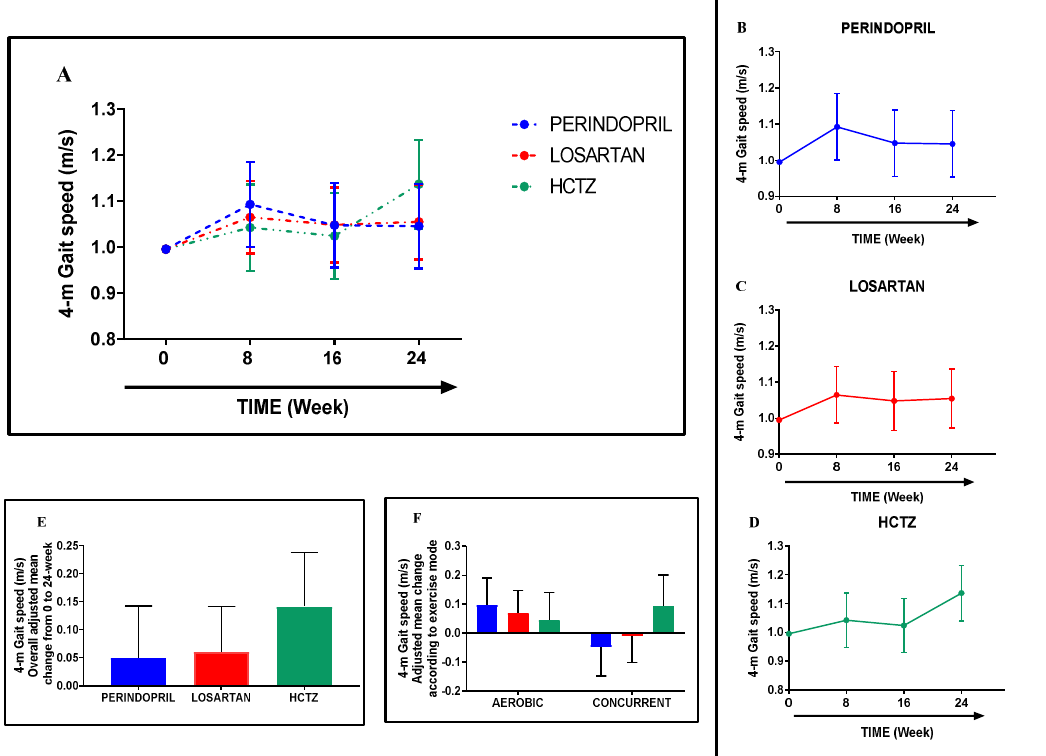
Figure 3. Adjusted mean change in gait speed from baseline to 24-week follow-up according to the randomization group ( A – D ). Overall adjusted mean change was within groups ( E ) and according to exercise mode ( F ). Data are expressed as adjusted mean change within groups with 95% confidence intervals adjusted to age, sex, and baseline status.